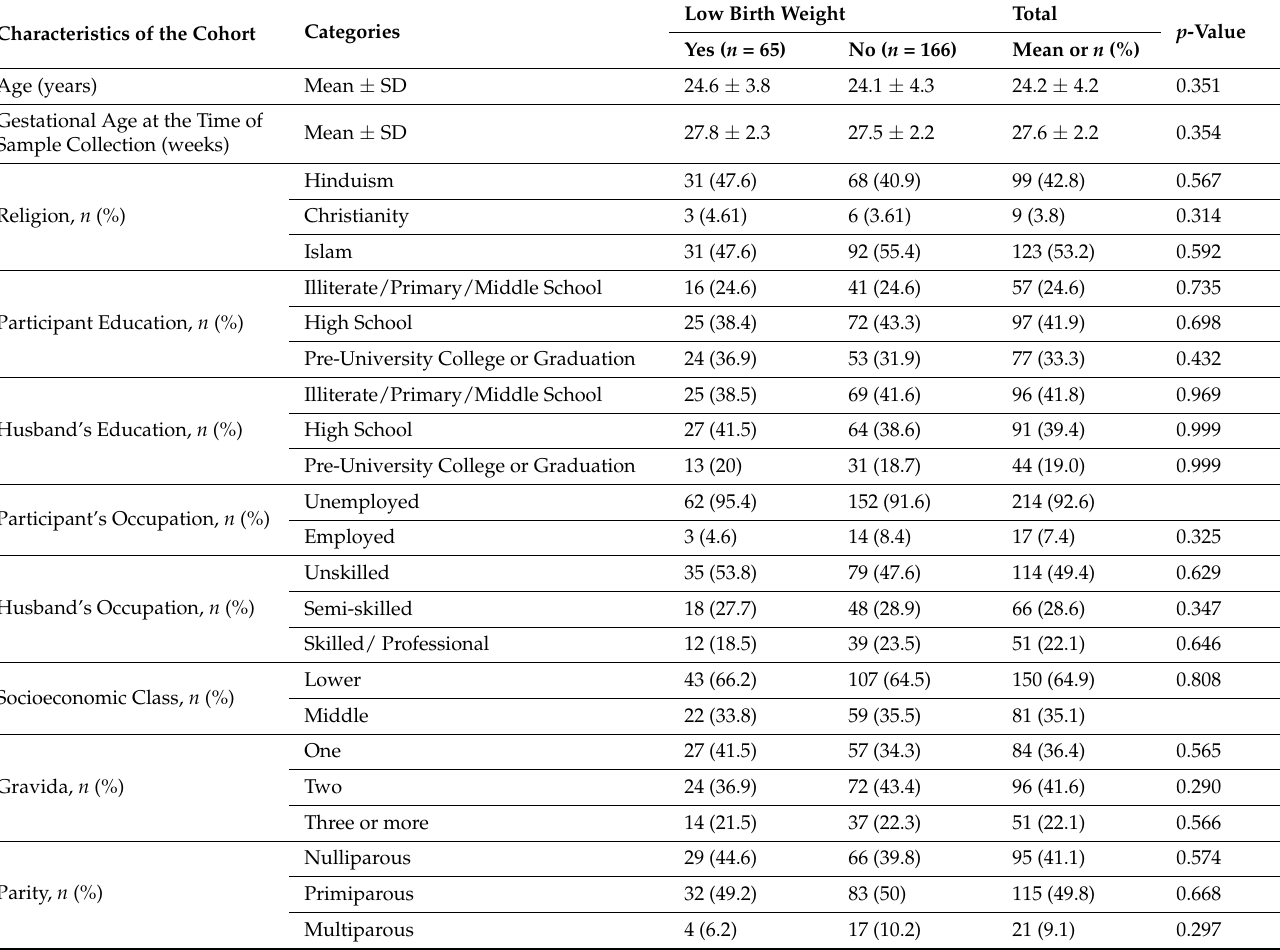
Table 1. Baseline characteristics of pregnant women with and without LBW